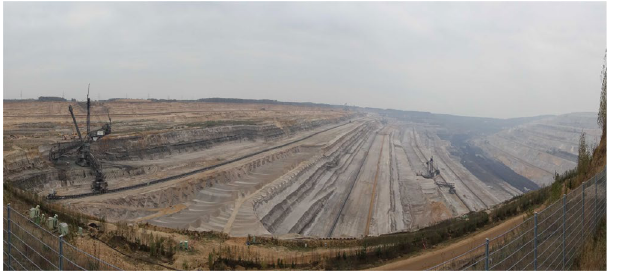
Figure 1. View of the extraction side of the lignite opencast mine Hambach (left hand side) with a surface of 85 2 km and depth 400 m created with coal excavator and dumping site (right hand side) 1 .